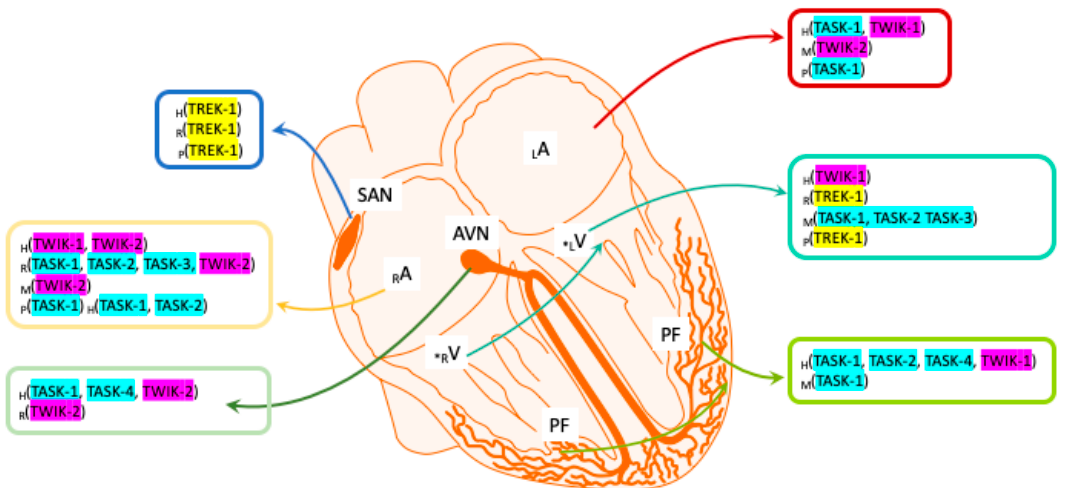
Figure 1. Scheme of the most prominently expressed K2P channels in the mammalian heart: TREK, TASK and TWIK. P, porcine; H, human; M, mouse; R, rat; SAN, sinoatrial node; AVN, atrioventricular node; PF, Purkinje fibers; RA and LA: right and left atrium; RV and LV: right and left ventricle—* right or left ventricular not specified.